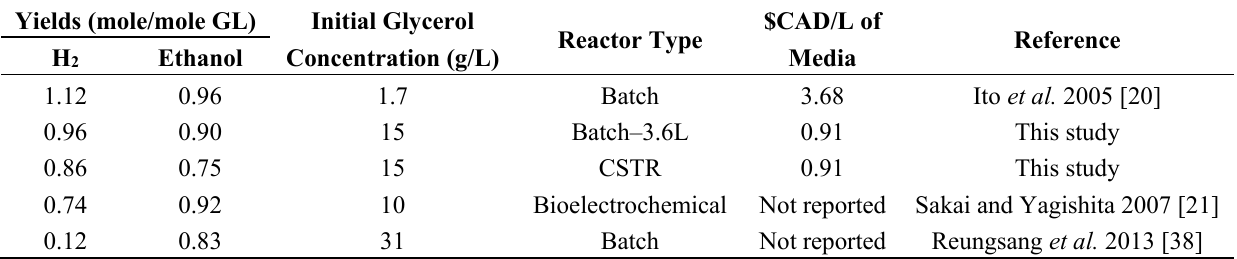
Table 1. Comparison of media cost, hydrogen and ethanol yields for the conversion of crude glycerol in batch and continuous systems using various strains of Enterobacter aerogenes